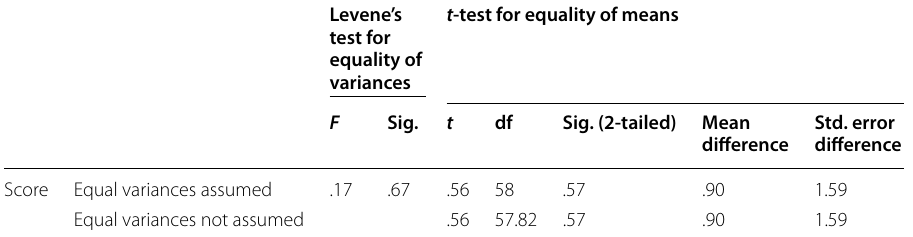
Std. error difference difference